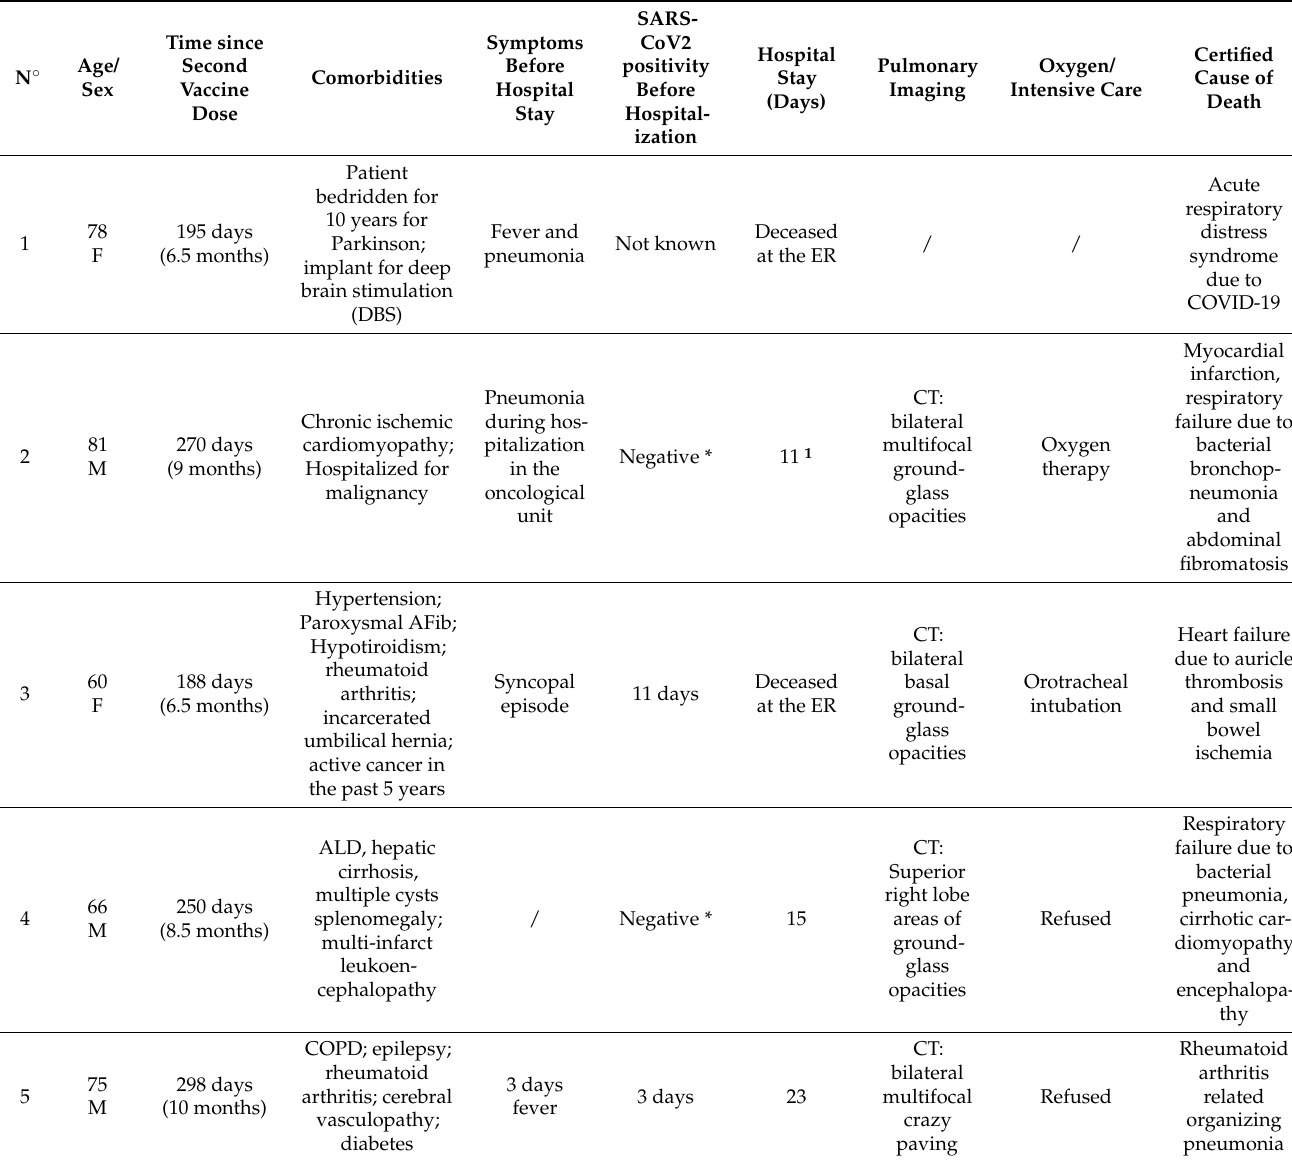
Table 1. Demographic, and clinical course of vaccinated